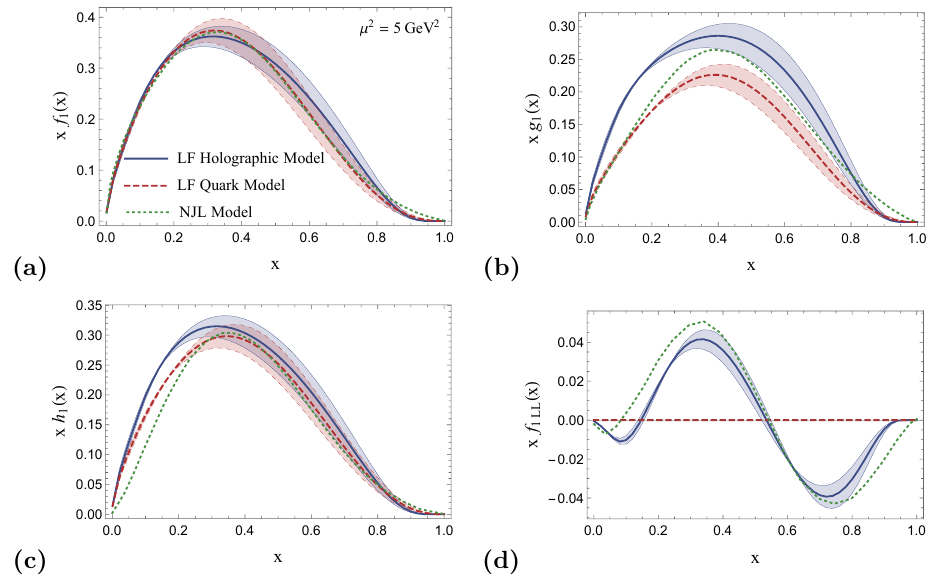
Figure 9 . The evolved PDFs for ρ meson: (a) xf 1 ( x ) , (b) xg 1 L ( x ) , (c) xh 1 ( x ) and (d) xf 1 LL ( x ) as functions of x . The blue bands are LF holographic model results evolved from the initial scale µ 2 = 0 . 20 ± 0 . 02 GeV 2 using the NNLO DGLAP equations to the scale µ 2 = 5 GeV 2 . The red LFH bands are LF quark model results evolved from the initial scale µ 2 same final scale. The green dotted lines represent the results from the NJL model